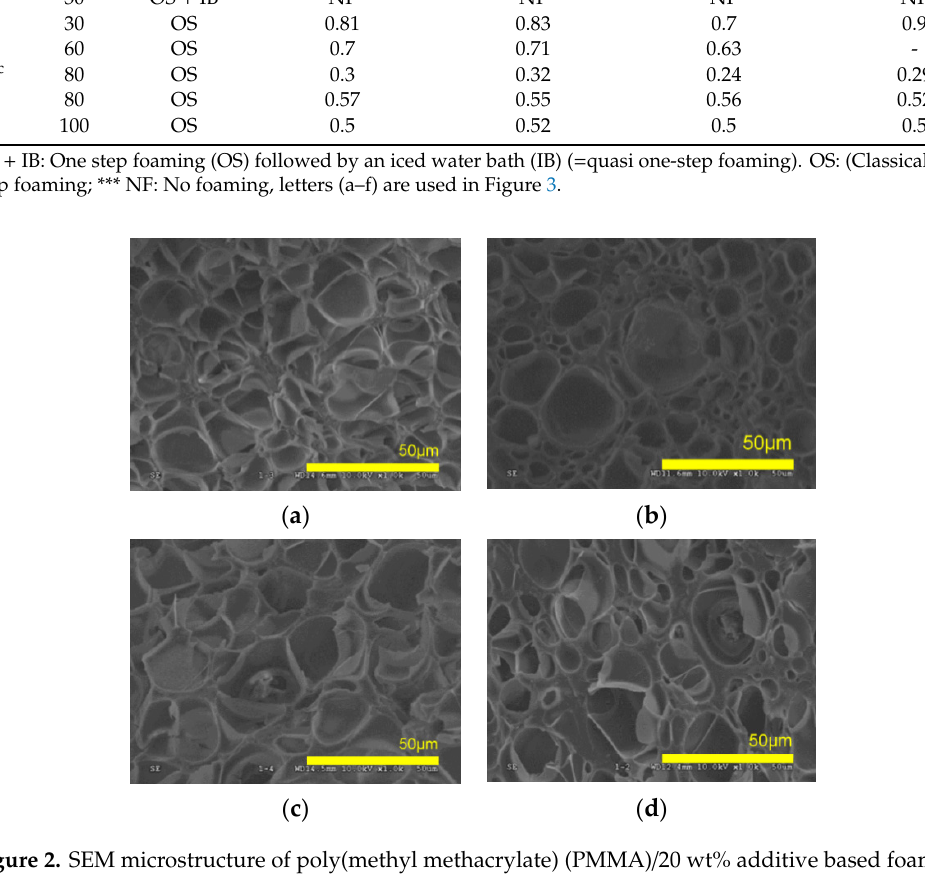
Table 4. Set of experiments II: Density variations observed in various batch foaming conditions (P sat , T sat ).